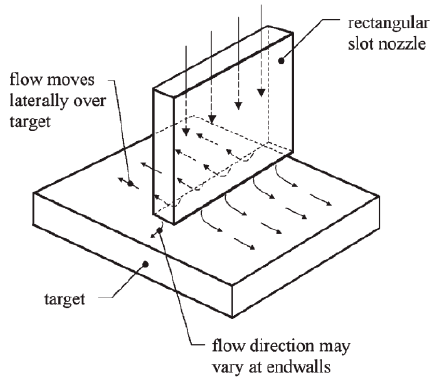
Figure 2. Slot jet configuration.